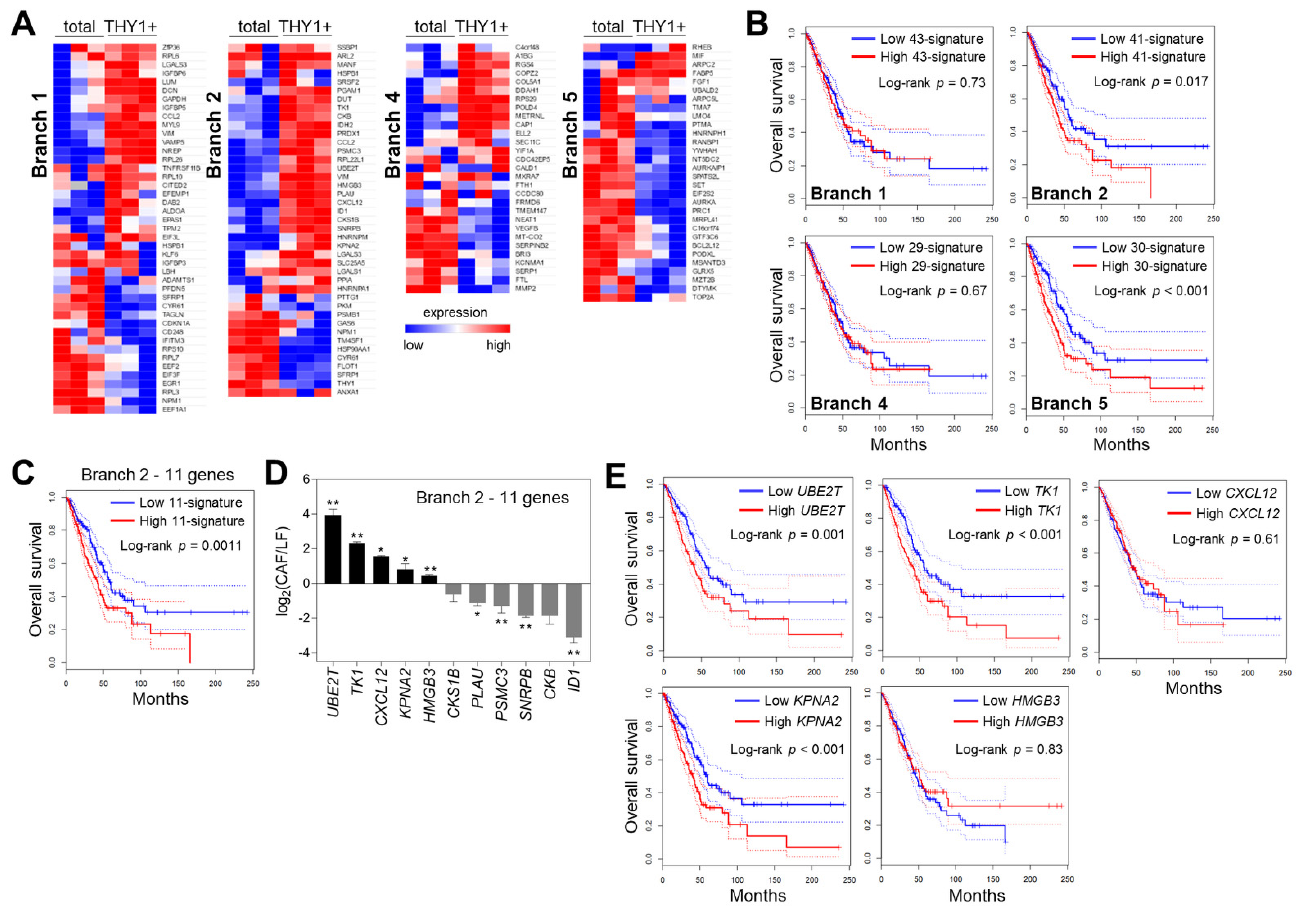
Figure 4. Characterization of branch-specific markers. ( A ) Heatmaps of branch-specific marker expression measured via qRT-PCR in total and THY1 + CAFs. ( B ) Kaplan–Meier plots showing overall survival of lung adenocarcinoma patients (TCGA data, n = 478) divided by the median into two groups (high and low) according to the expression levels of branch-specific markers. Dotted lines represent 95% confidence intervals. p -Values were determined via the log-rank test. ( C ) A Kaplan– Meier plot showing the effect of 11 signature genes ( UBE2T, TK1, CXCL12, KPNA2, HMGB3, CKS1B, PLAU, PSMC3, SNRPB, CKB , and ID1 ) from Branch 2 on the overall survival of lung adenocarcinoma patients (TCGA). ( D ) qRT-PCR analysis of 11 genes from Branch 2 in mouse normal lung fibroblasts (LFs) and CAFs. Data are presented as the mean + SD ( n = 3). * p < 0.05, ** p < 0.01; two-tailed Student’s t -test. ( E ) Kaplan–Meier plots showing the effects of UBE2T , TK1 , CXCL12 , KPNA2, and HMGB3 expression on the overall survival of lung adenocarcinoma patients (TCGA).